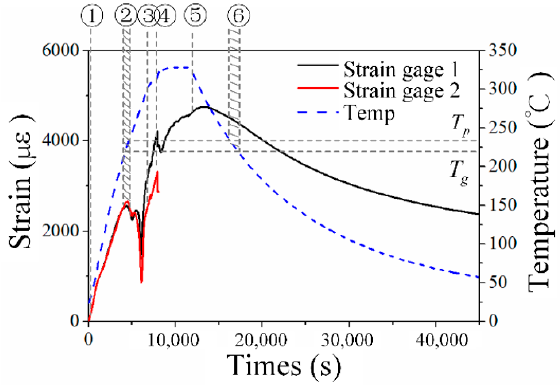
Figure 14. Experimental internal strain.